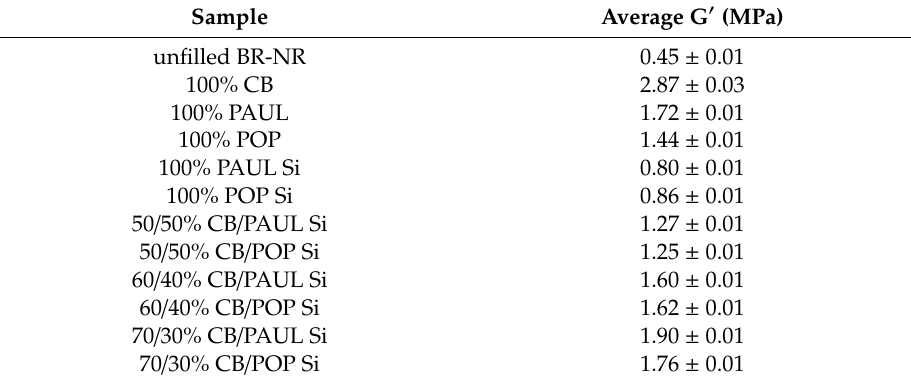
Table 5. Small-strain Cyclic Behavior of BR-NR Composites with 33 wt % Total